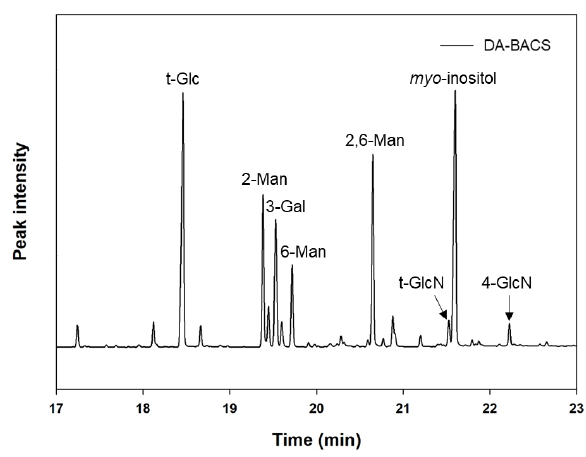
Microorganisms 2022 , 10 , x FOR PEER REVIEW 12 of 24